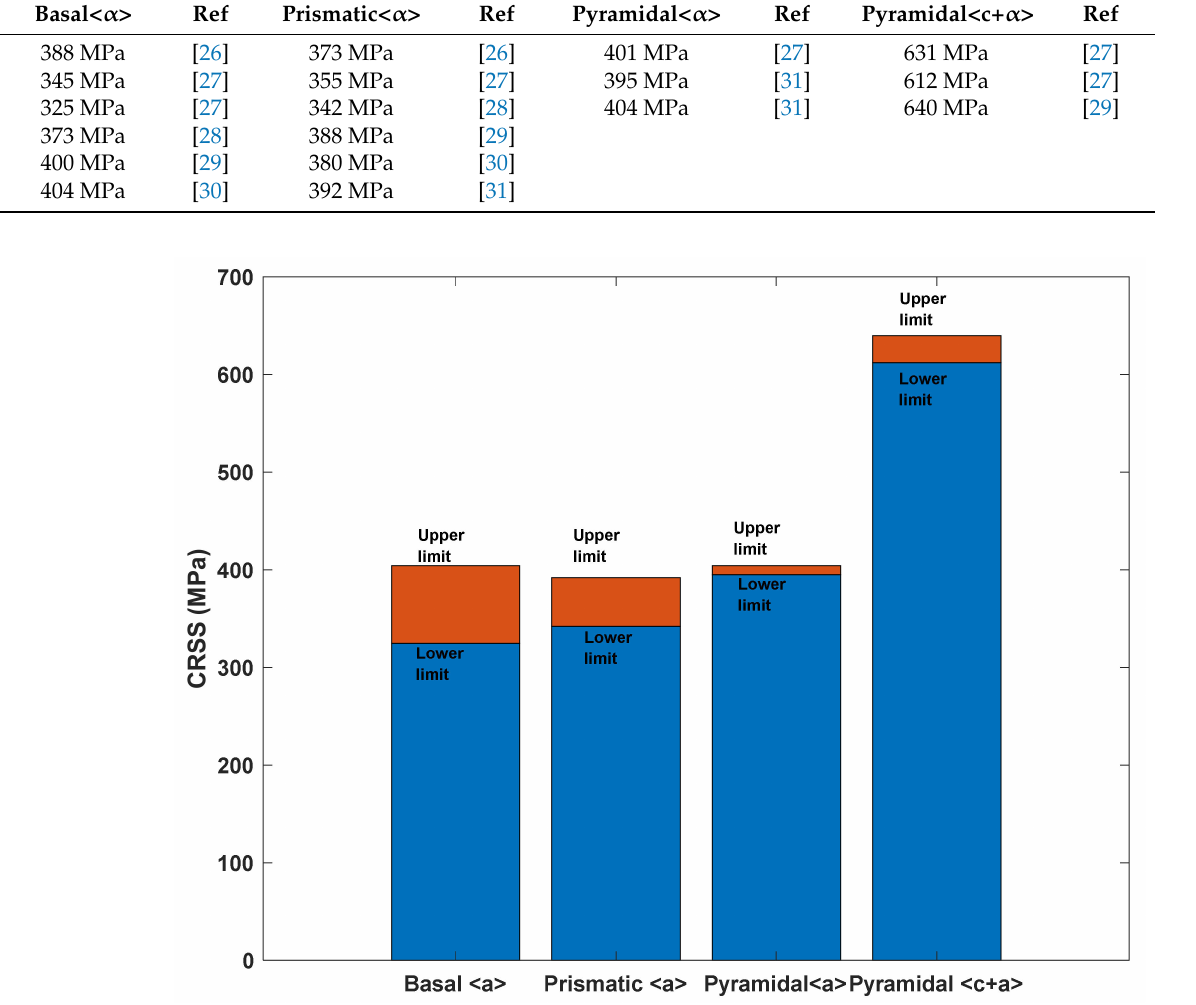
Figure 10. Comparison of the range of values of CRSS for different slip systems in